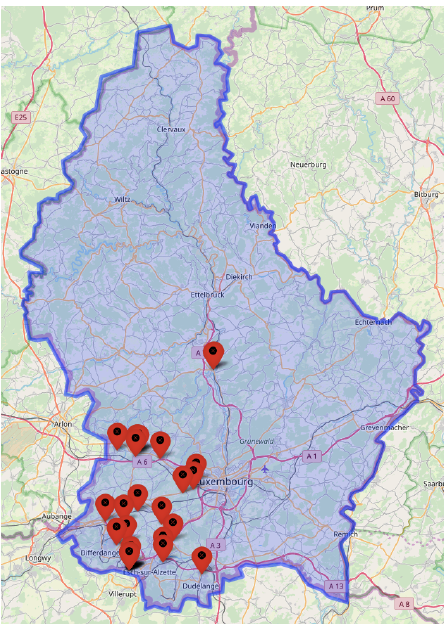
Figure 25. Physical deployment: 47 sensors were integrated in 35 distinct sites.